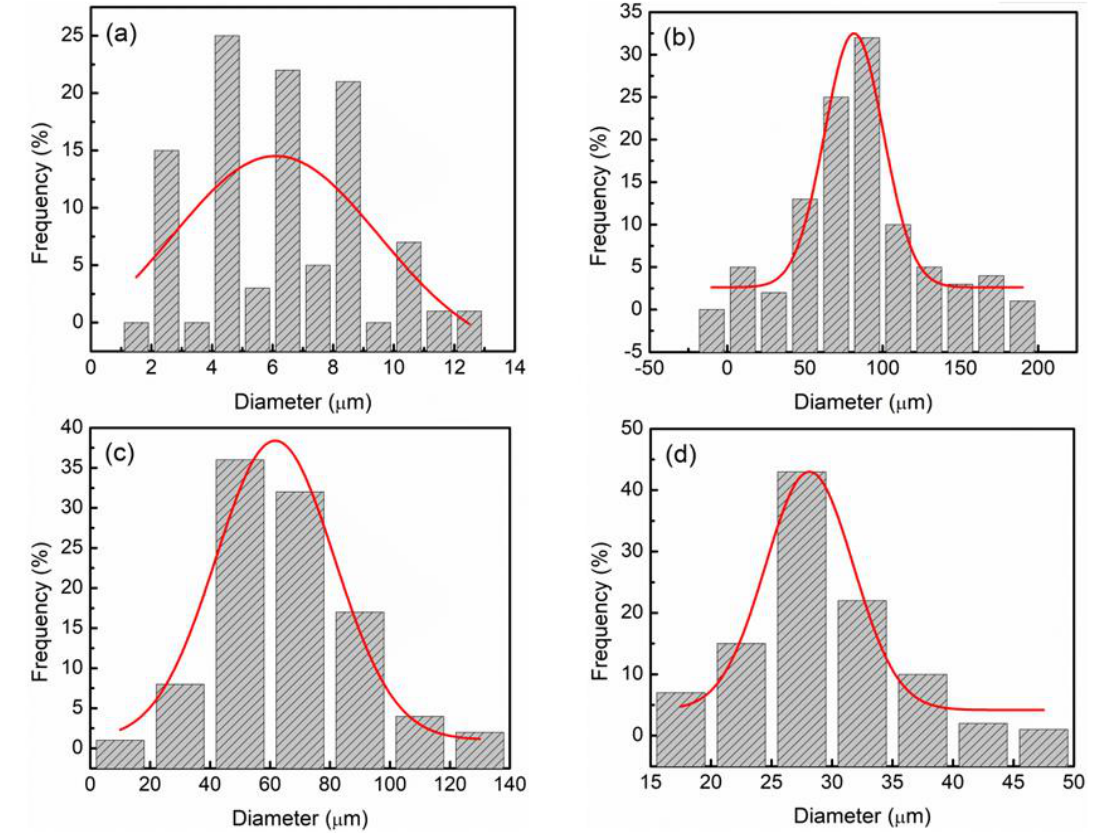
Figure 5. Particle size distribution histograms of the ( a ) as-obtained TiSiO 4 , ( b ) as-obtained LiAlH 4 , ( c ) post-milled LiAlH 4, and ( d ) LiAlH 4 added with 10 wt% TiSiO 4 .